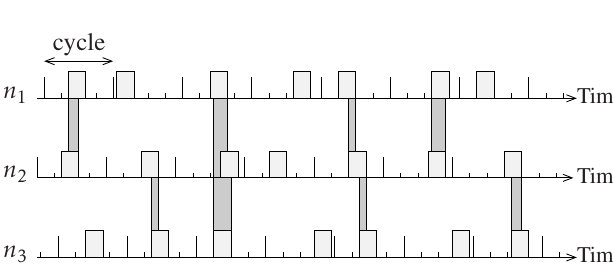
Figure 1. Example of the activities of three neighbor nodes with the protocol of [26], with a duty-cycle of 25% (this long duty-cycle is chosen for clarity).